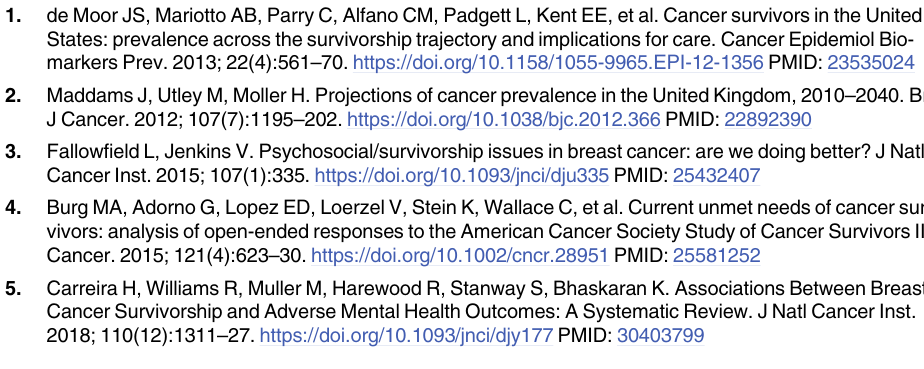
patients excluded and number and mean follow-up time of patients available for analyses: pain, opioids analgesics, and fatal and nonfatal self-harm. S2 Table. Cumulative incidence of adverse mental health outcomes, fatigue, and pain in breast cancer survivors and in women who did not have cancer. S3 Table. Table A: adjusted associations between breast cancer survivors and anxiety, depres- sion, cognitive dysfunction, and fatigue. Table B: adjusted associations between breast cancer survivors and sexual dysfunction, sleep disorders, pain, opioid prescription, and fatal and non- fatal